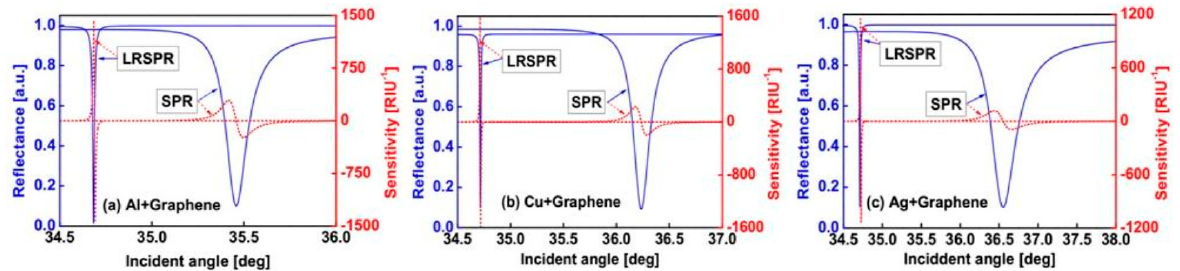
Figure 5. Reflectance and sensitivity on standard and long-range surface plasmon resonance (LRSPR) structure for ( a ) Al+graphene, ( b ) Cu+graphene, and ( c ) Ag+graphene (adapted with permission from Reference [37], copyright IEEE).